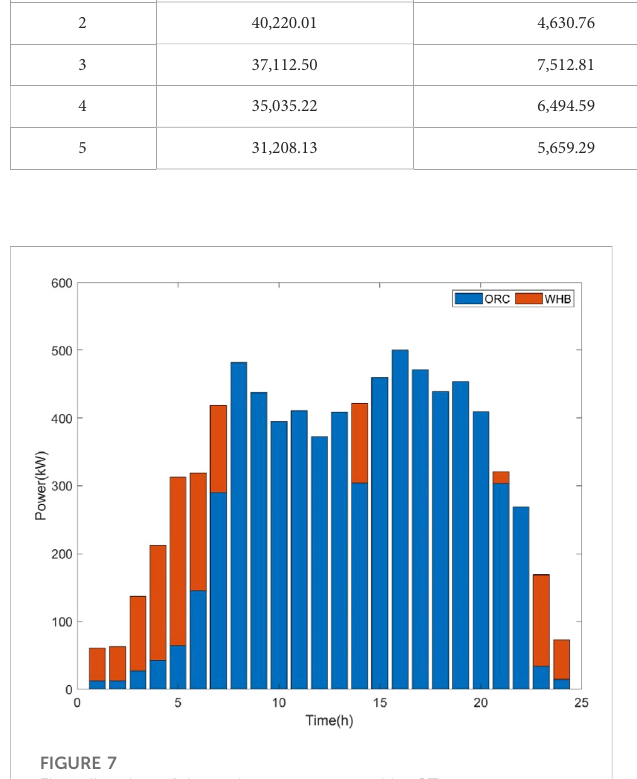
FIGURE 8 Heat source input into ORC.